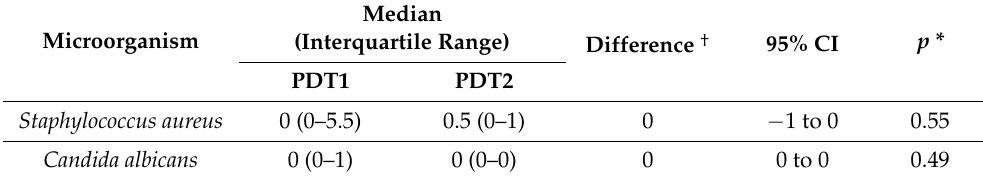
Figure 13. Difference in the number of Candida albicans CFUs between groups (NC, PC, PDT1, PDT2). ▴ Outliers; * Statistically significant difference. Table 3. Difference in CFUs of PDT1 and PDT2.